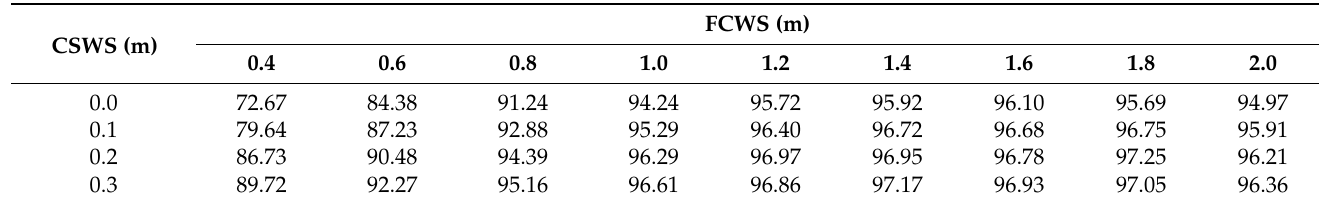
Table 2. The influence of different combinations of circular smoothing window size (CSWS) and fixed circular window size (FCWS) on the precision (%) of Casuarina equisetifolia detection.